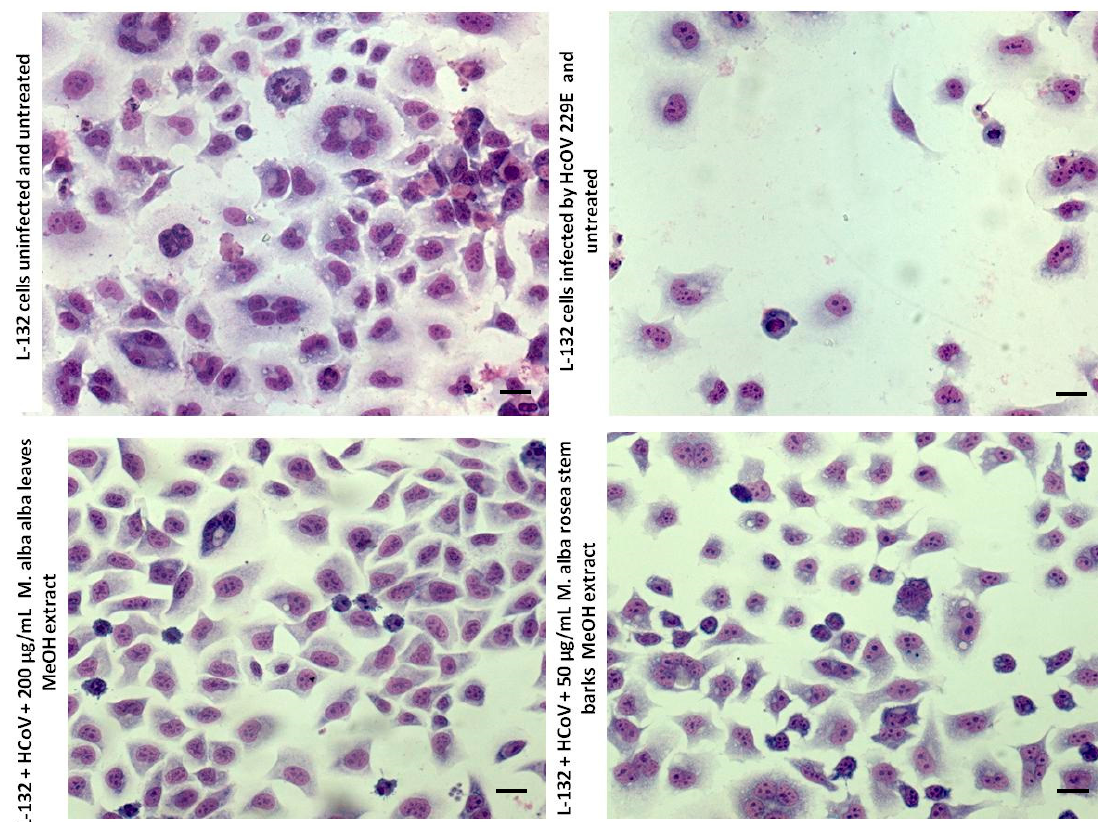
Figure 2. Human coronavirus (HCoV) 229E cytopathogenic effects observed with hydromethanolic extracts of Morus alba var. alba leaves and Morus alba var. rosea stem barks. Scale bar, 20 µm.